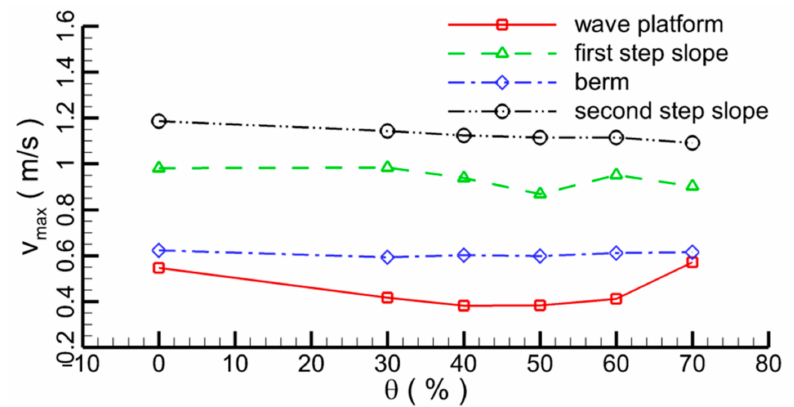
Figure 11. Variation of maximum velocity with gap ratio at different